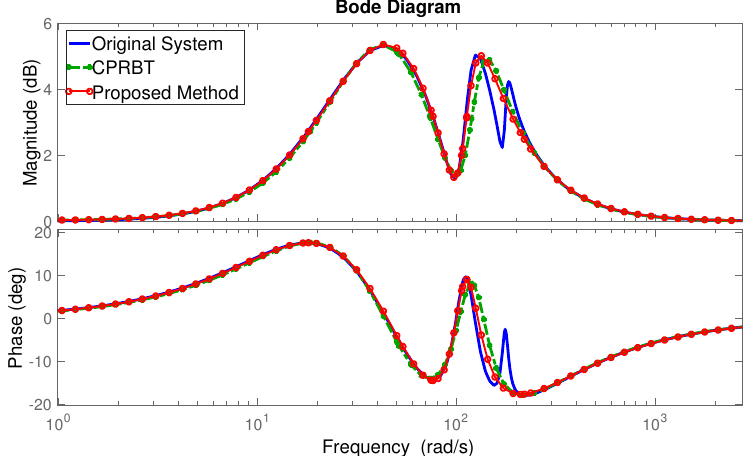
Figure 3. The bode diagrams of the original system, the CPRBT reduced model, and the proposed reduced model in Example 2.